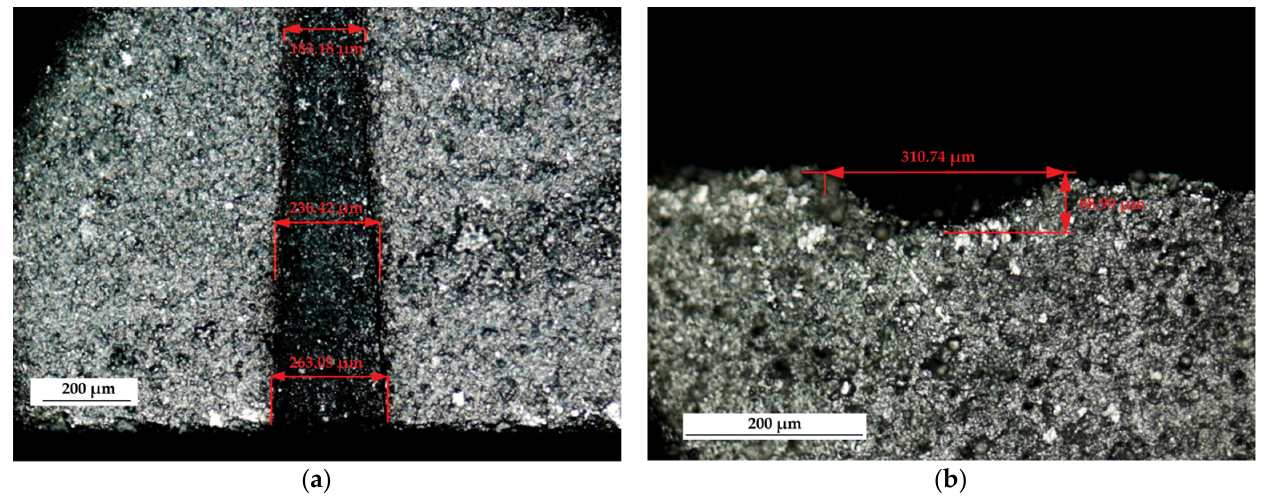
Figure 6. The obtained slot (kerf) with a depth of 68.99 µm at pulse duration D = 2 µs, optical mi- croscopy, general view ( a ), top view ( b ). microscopy, general view ( a ), top view ( b